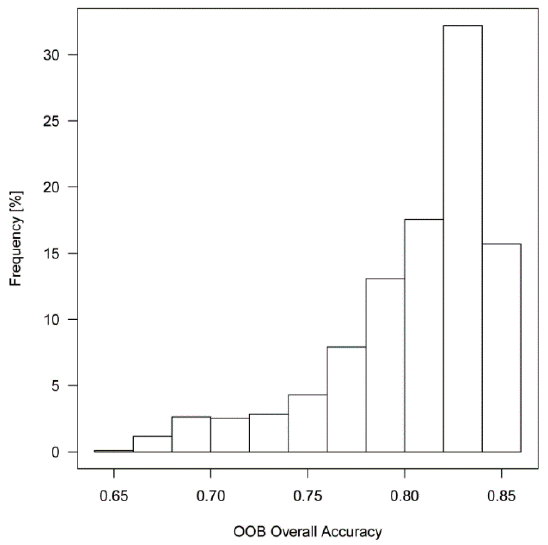
Figure 6. Distribution of the OOB overall accuracies of the 1025 RF-models based on different segmentations (combining samples A and B). The reported accuracies were obtained after model-specific feature selection in the RF modeling. The best OOB models yields an overall accuracy of 0.858 (kappa =